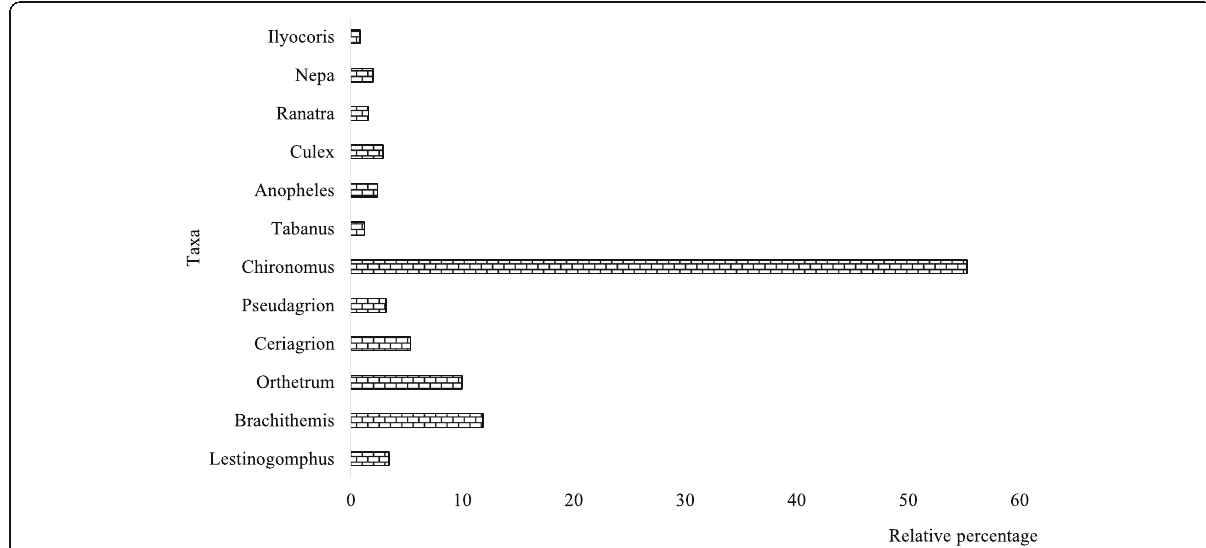
Fig. 2 The relative percentage of aquatic insects per genus, from March to August 2017, in Aahoo stream, Akure,